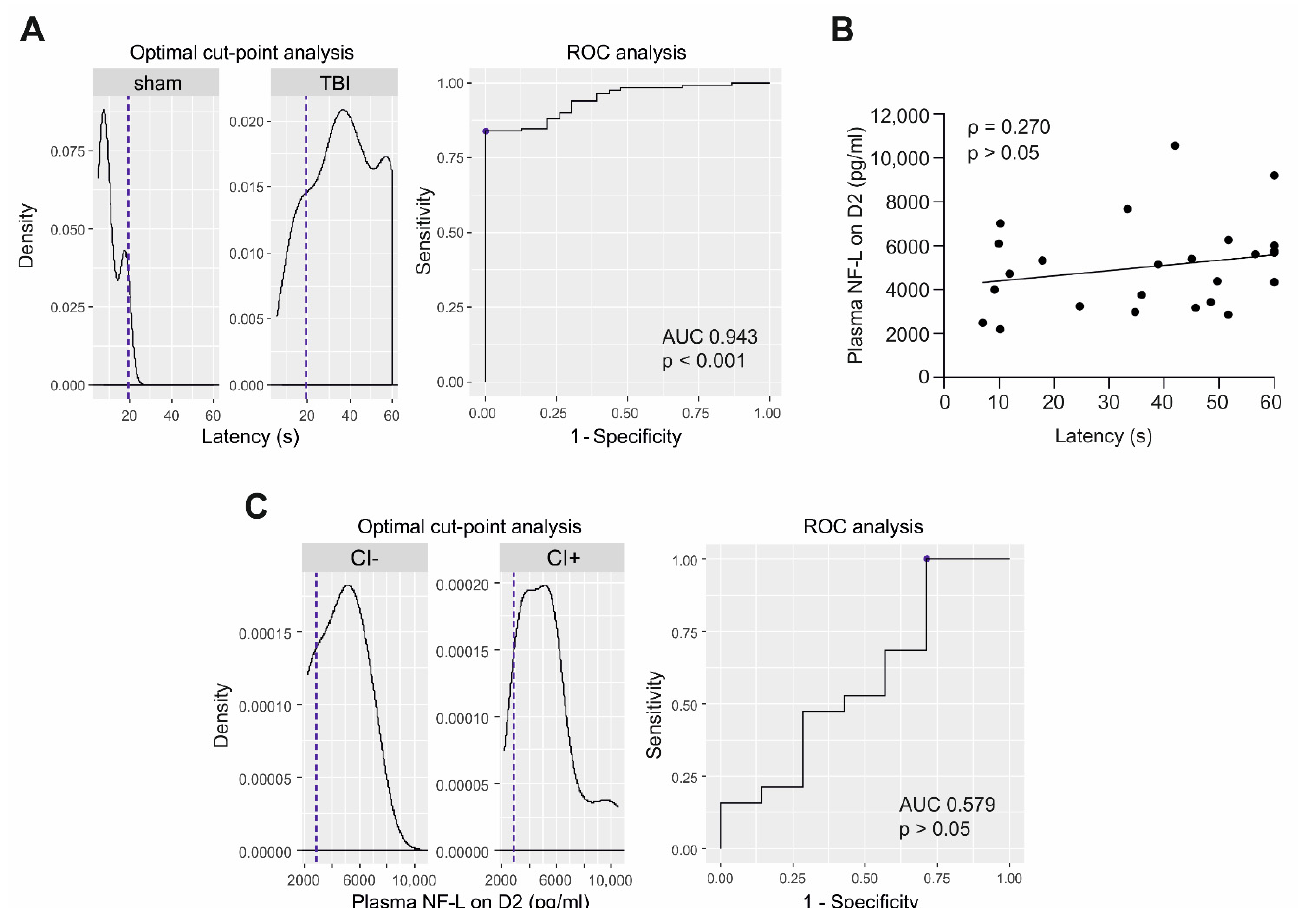
Figure 5. Plasma NF-L and cognitive impairment after TBI. ( A ) Optimal cut-point analysis was performed in the EPITARGET animal cohort to identify parameters that differentiate cognitively impaired (CI+) and non-impaired (CI − ) rats. The cut-point latency of 19.2 s (i.e., latency to reach the platform in the Morris water maze (MWM) on the 3rd day of testing, i.e., on D37, dashed line) differentiated TBI (n = 118) and sham-operated rats (n = 23) with AUC 0.94 ( p < 0.001) and was set as a limit for cognitive impairment. ( B ) No correlation was detected between plasma NF-L levels on D2 and MWM latency on D37 (Spearman correlation rho ( ρ ) = 0.270, p > 0.05, n = 26). ( C ) Accordingly, ROC analysis indicated that plasma NF-L levels did not distinguish CI+ (latency > 19.2 s) from CI − (<19.2 s) rats (AUC 0.58, p > 0.05, Mann-Whitney U test). Abbreviations: AUC, area under the curve; D2, day 2 post-TBI; ROC, receiver operating characteristics; TBI, traumatic brain